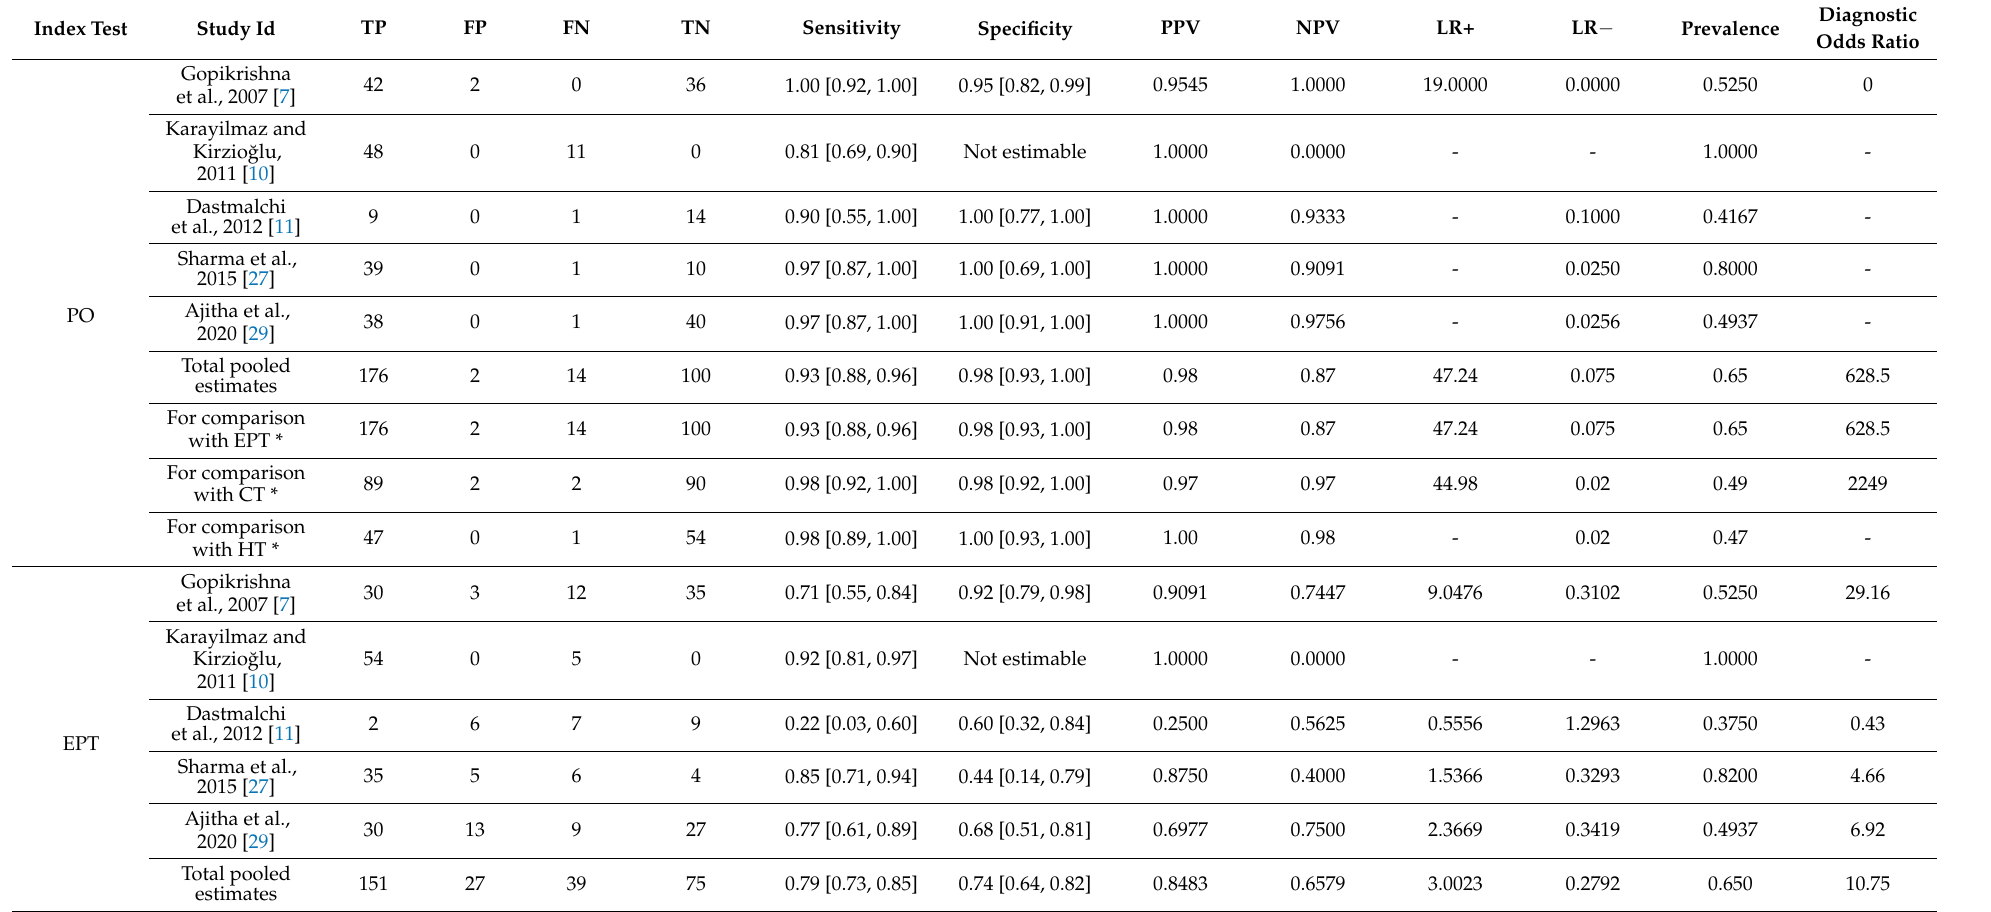
Table 3. Diagnostic accuracy of pulp vitality and sensibility tests for the studies included in